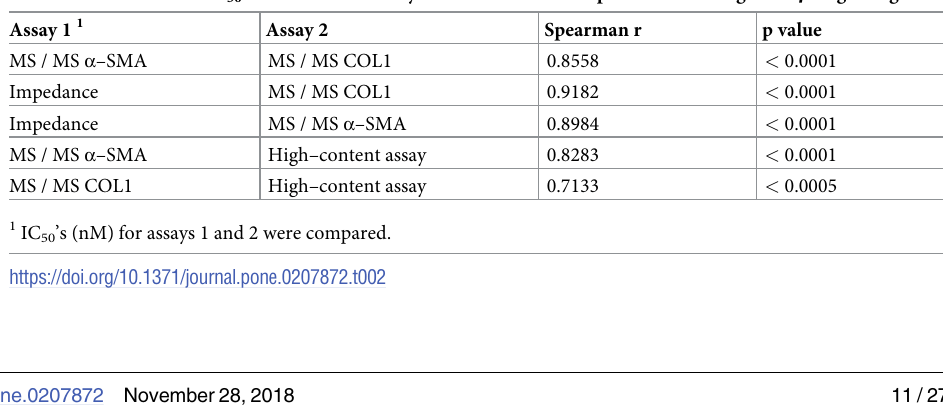
the HCA (Table 3 and S3 Fig), blocked TGF– β 1–induced effects in IPQA, and inhibited α – SMA and COL1 neo–synthesis (Table 3 and S3 Fig). It also reduced cell surface area, as evi- denced by the CellMask Orange stain, at concentrations � 1250 nM, and reduced the number of nuclei with IC 19 μ M (n = 1; Table 3) in the HCA. 50